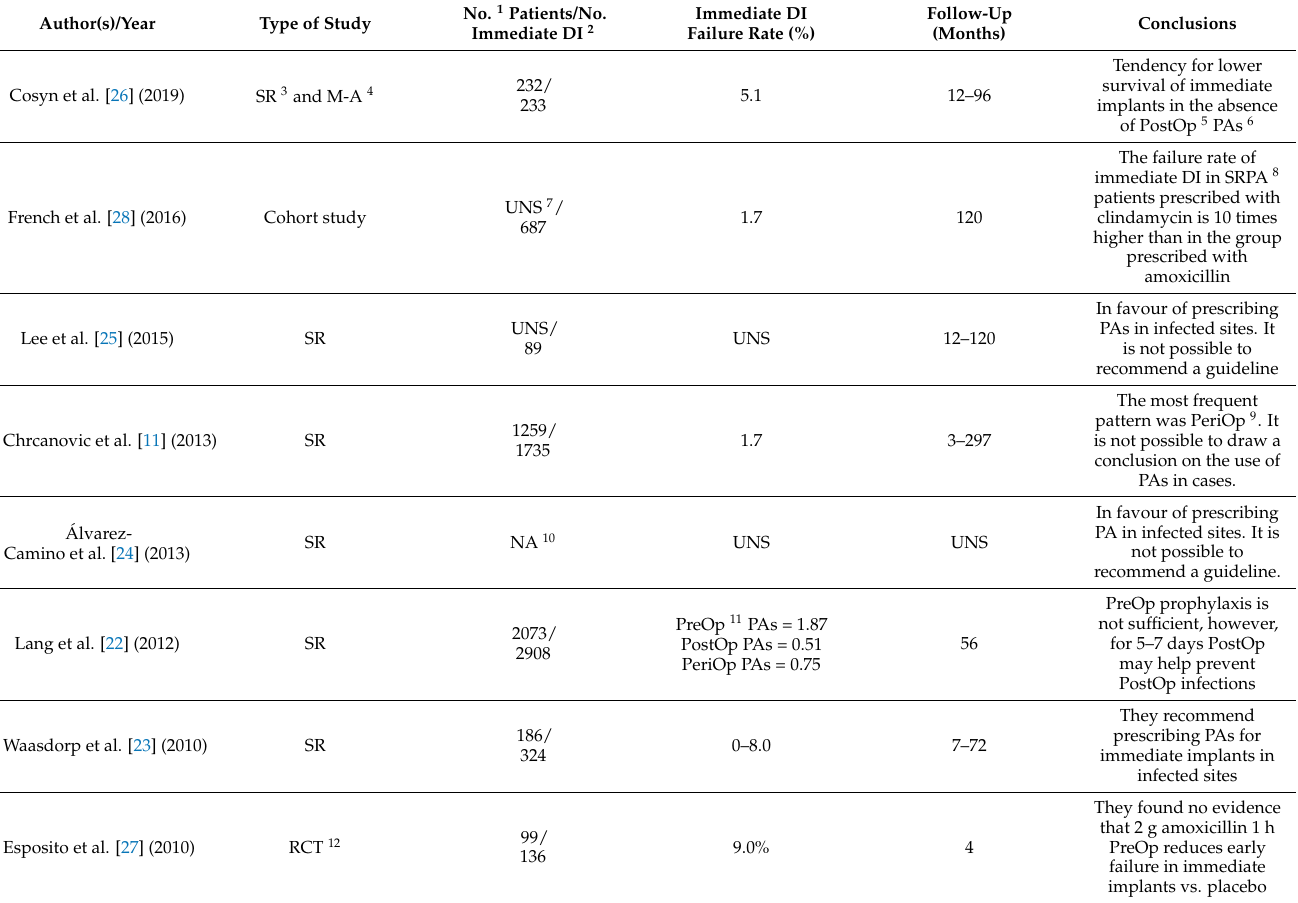
Table 2. Results of included studies. Data on immediately placed implants were